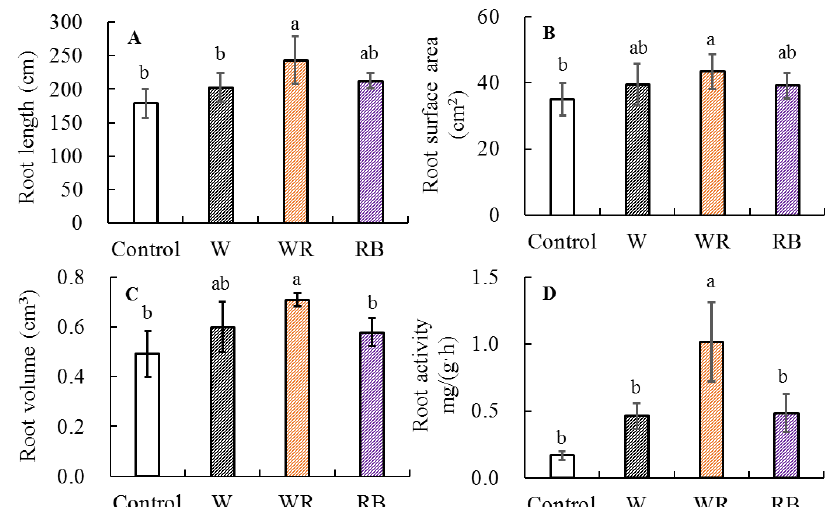
Figure 3. The effects of supplementary white LEDs, white plus red LEDs, and red plus blue LEDs on the root length ( A ), root surface area ( B ), root volume ( C ), and root activity ( D ) of the greenhouse- grown tomato seedlings, and tomato seedlings grown under sunlight only were regarded as the control. Different letters on top of bars denote significant differences according to the LSD test ( p < 0.05). Error bars represent the mean ±